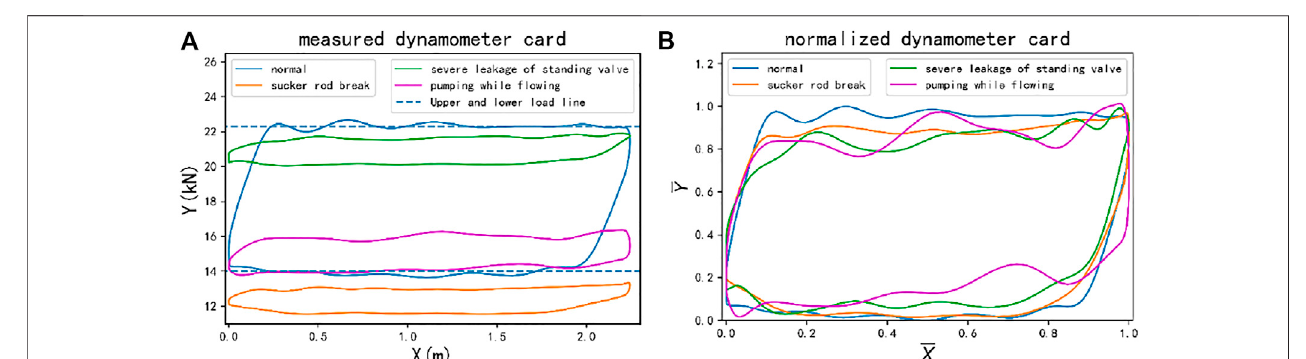
FIGURE 1 | Normalized dynamometer card for the four working conditions.